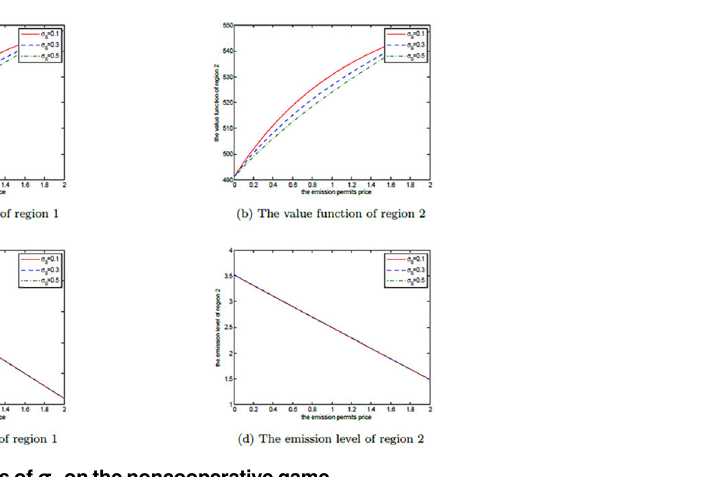
Fig 11. The effects of σ S on the noncooperative game.